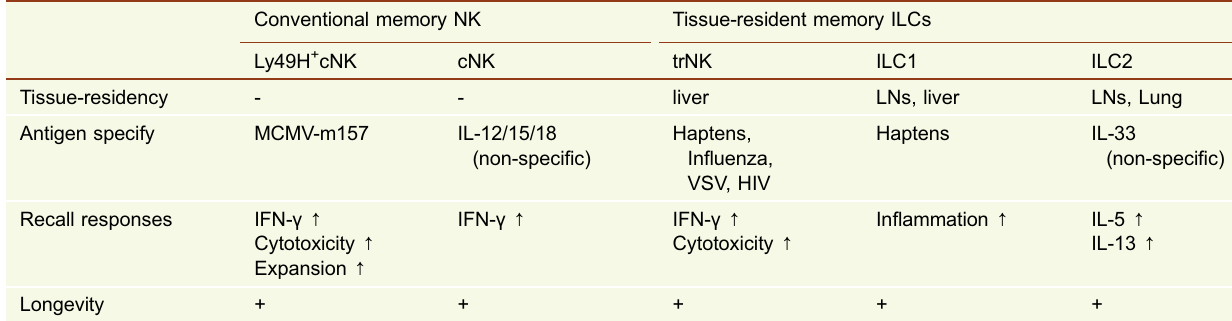
Table 1. Characteristics of tissue-resident memory ILCs and conventional memory NK